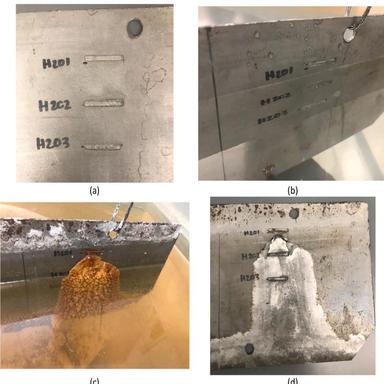
Sample B before and after SCC test setup condition; (A) before SCC, (B) in corrosive solution, (C) DAY 40 in corrosive solution, (D) DAY 40 out of corrosive solution.